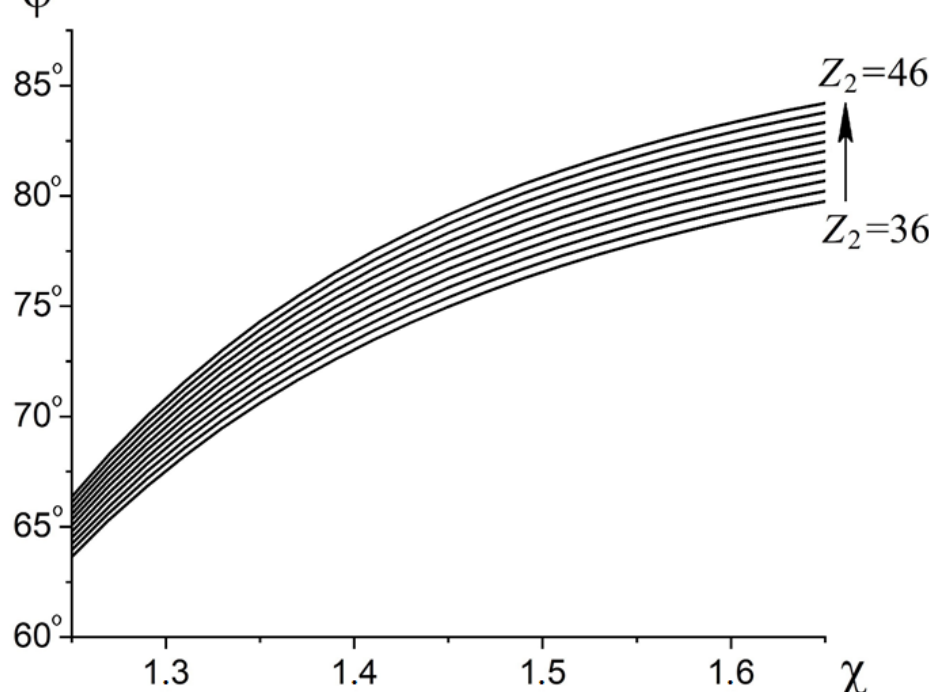
Figure 6. Dependence of the maximum contact stress angle on the displacement coefficient χ at different values of the rolling elements number Z 2 .